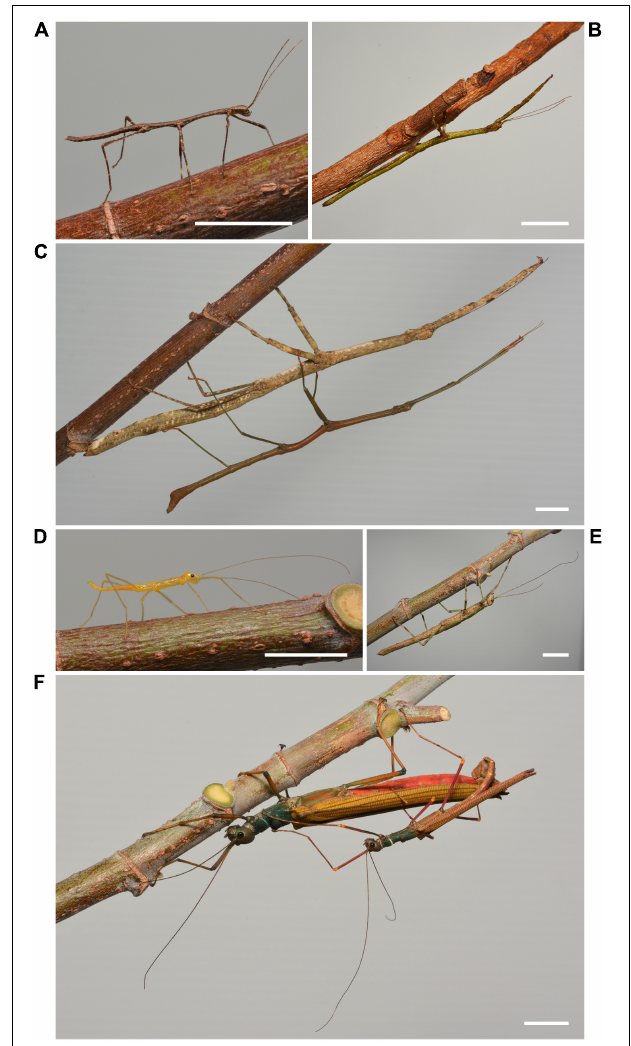
FIGURE 1 | A typical stick-like phasmid, Lonchodes brevipes , and a brightly colored phasmid, Calvisia flavopennis , at different life stages: (A) first-instar nymph of L. brevipes ; (B) late-instar nymph of L. brevipes ; (C) L. brevipes adults, with the male hanging from the female; (D) first-instar nymph of C. flavopennis ; (E) late-instar nymph of C. flavopennis ; (F) . C. flavopennis adults, with the smaller male copulating with the female. The white bar represents 10 mm in each